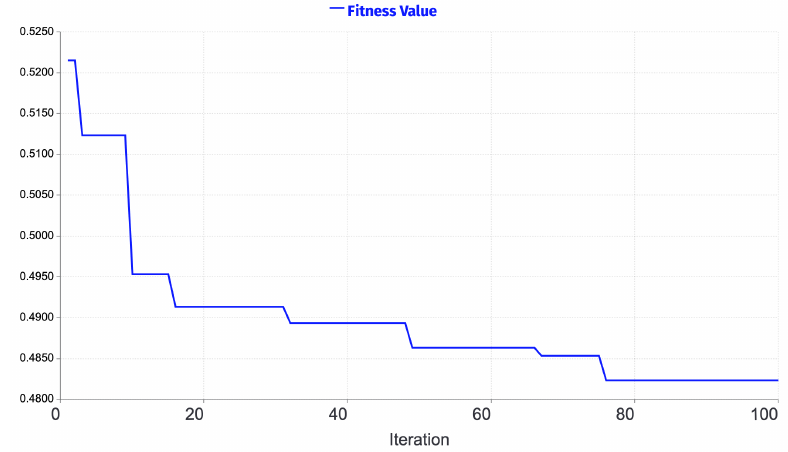
Figure A6. The training convergence curve when using the ANN with the CSO and the coast sensitivity fitness function for the dataset of Spanish companies.